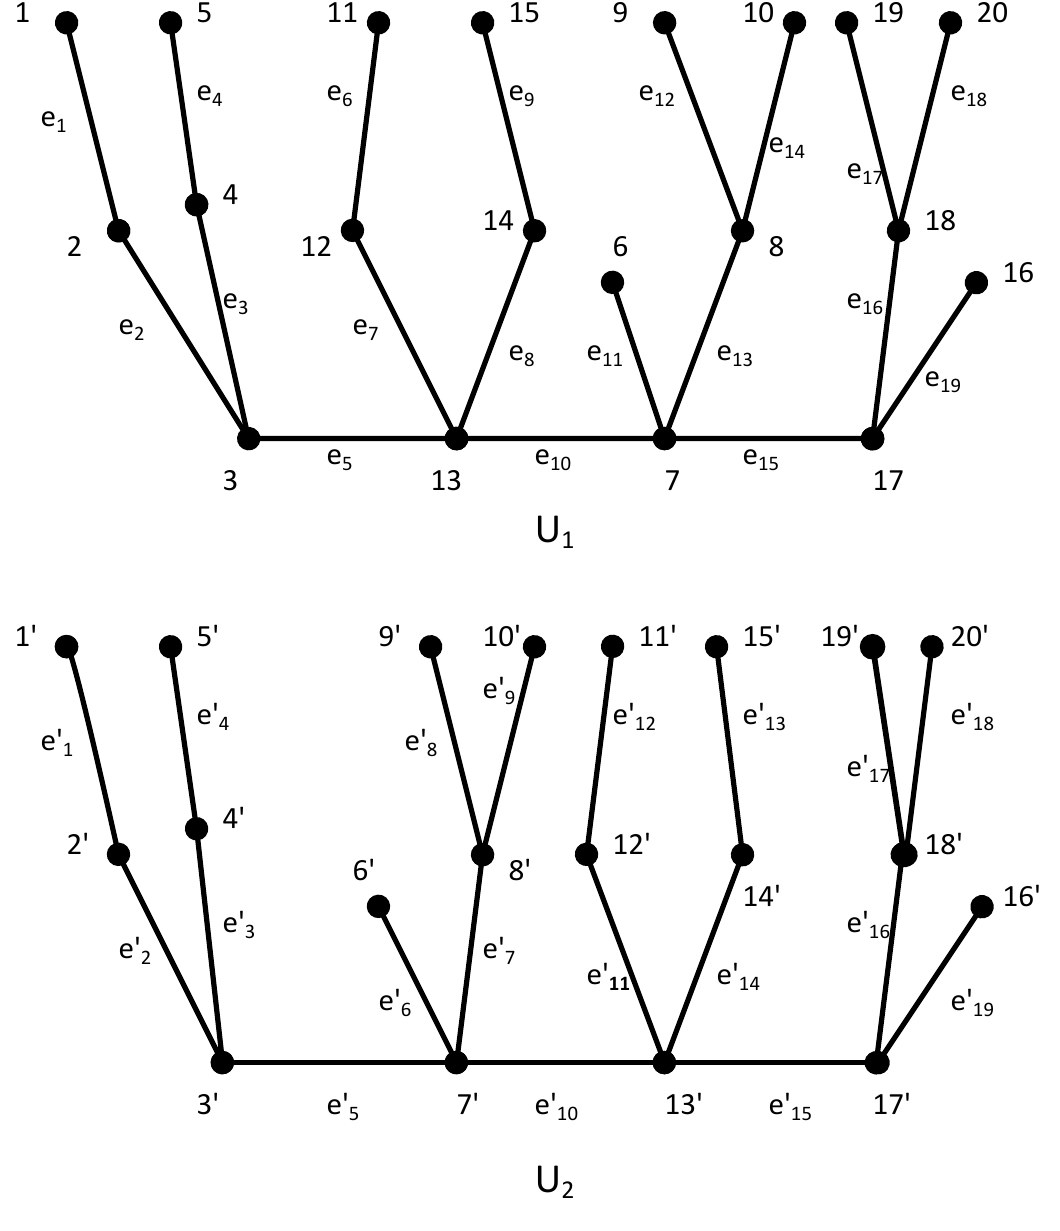
Figure 2: Minimal pair of non-isomorphic trees with the same Randi´c-table and path- table.